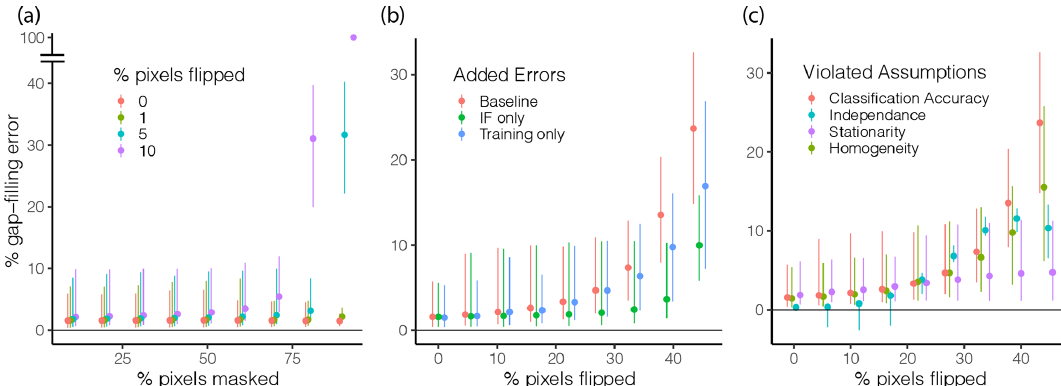
Figure 3. Results of the numerical experiments. (a) Gap-filling errors resulting from various combinations of independent random errors in cloud (percent of pixels masked) and water (percent of pixels flipped) detection. (b) Origin of the gap-filling errors associated with faulty land/water detection. Images with introduced errors are alternatively used to construct the IF raster (green) or the training data set (blue), or both inputs (red) of the supervised classifier are used to estimate the status of masked pixels. (c) Effect of deviations from the four fundamental assumptions obtained from the four numerical experiments described in Sect. 2.2. The percent of gap-filling errors in (b and c) were evaluated by masking 5% of unmasked pixels in each image. These pixels were than used as validation data (step 1 in Sect. 2.2). Validation pixels were randomly and independently sampled for each